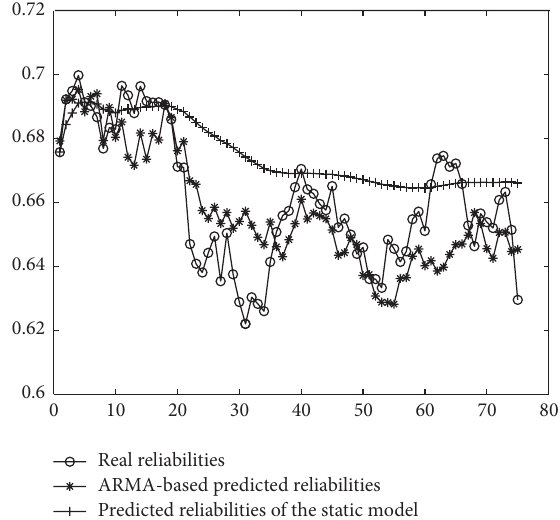
Figure 17: The comparison of the predicted PNCP and the actual